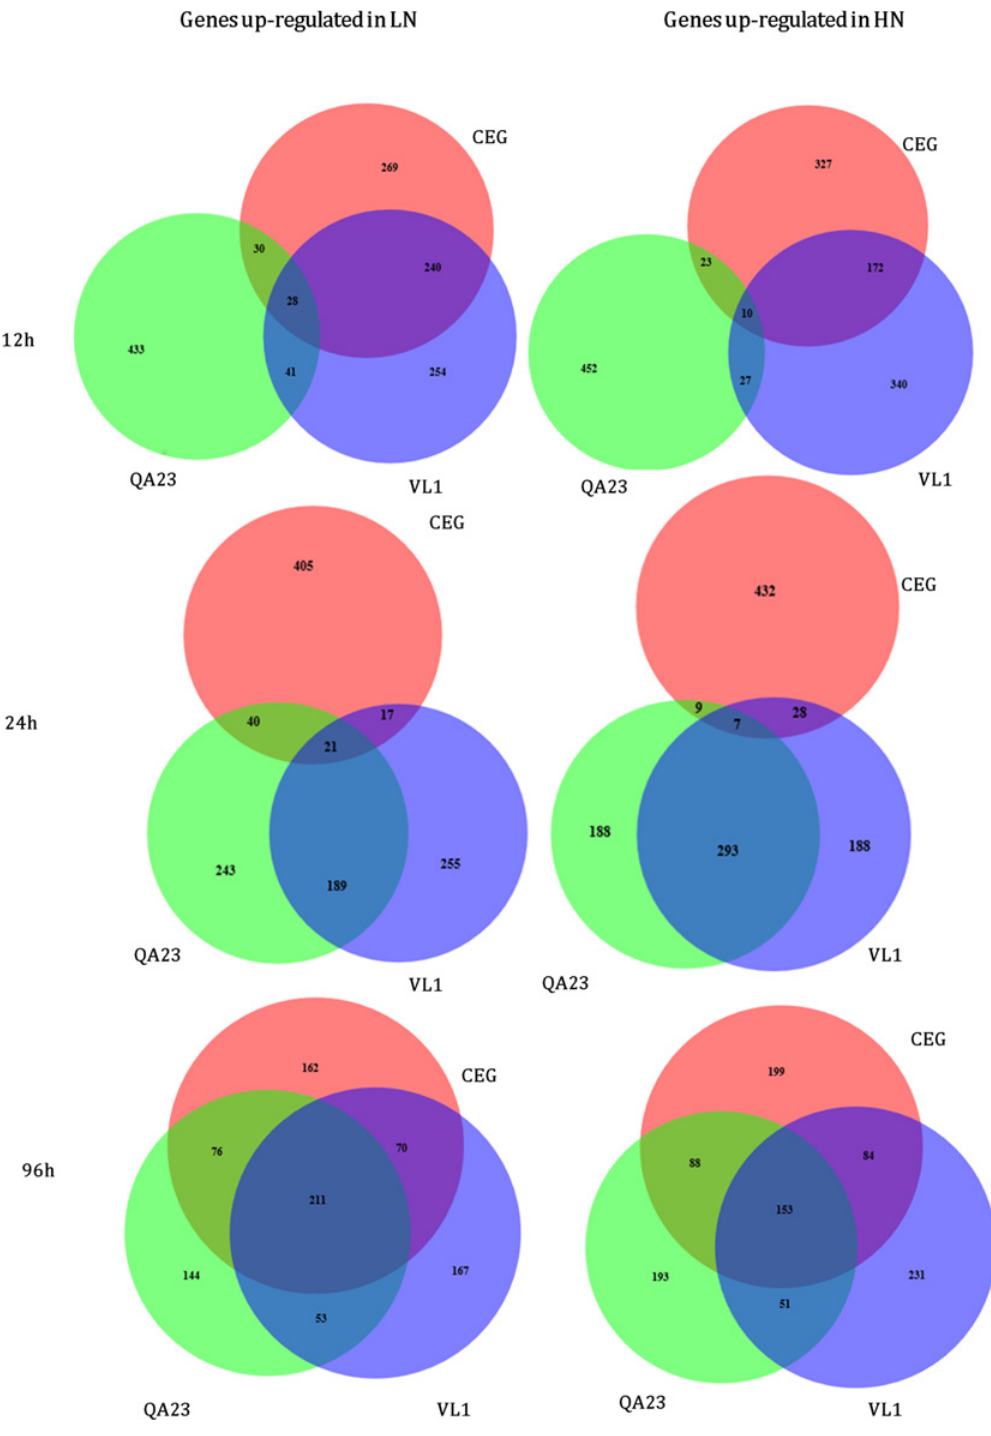
Fig 4. Venn diagrams for genes whose expression was significantly altered in the three wine yeast strains in LN and HN fermentations. Red indicated genes whose expression was altered in CEG, green in QA23 and violet in VL1.